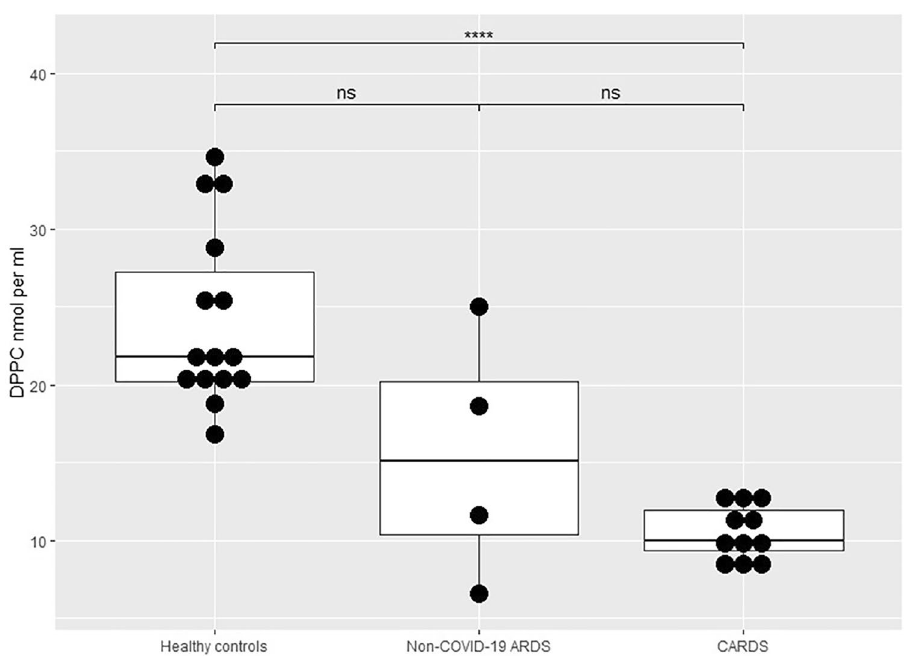
Figure 1. Dipalmitoylphosphatidylcholine (DPPC) levels (nmol/ml) measured in bronchoalveolar lavage fluid (BALF) in 15 healthy controls (M, 15; mean age, 23; SD, 2 years), in four patients with non-COVID-19 ARDS (M/F, 3/1; mean age, 68.5; SD, 3.9 years) and in 11 patients with CARDS (M/F, 10/1; mean age, 65.5; SD, 10.6 years). Boxplots depicts mean values with hinges corresponding to first and third quartile (the 25th and 75th percentiles). Lower and upper whiskers extend to smallest and highest value, respectively. Mann–Whitney U -test: P < 0.0001. CARDS, COVID-19 associated ARDS; DPPC, dipalmitoylphosphatidylcholine; NS, non- significant. **** P <